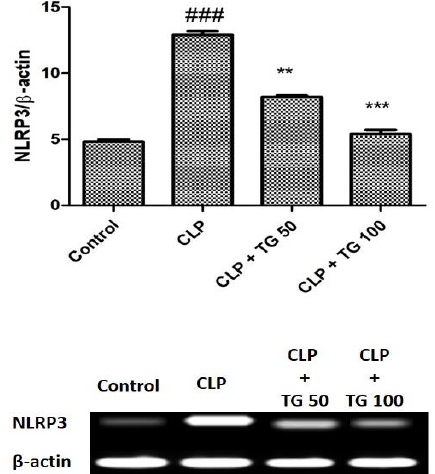
Figure 8. Relative nucleotide oligomerization domain (NOD)-like receptor family, pyrin domain containing 3 (NLRP3) expression. CLP increased the expression level of NLRP3 in myocardial tissue. TG (50 and 100 mg / kg) reduced the expression level of NLRP3 compared with CLP-treated rats at 24 h, dose-dependently. Values represented as means ± SD and n = 12 / group. One-way analysis of variance (ANOVA), followed by Tukey’s test were used for statically analysis. Where ### p < 0.001 when compared to control group, whereas ** p < 0.01 and *** p < 0.001 when compared with CLP group